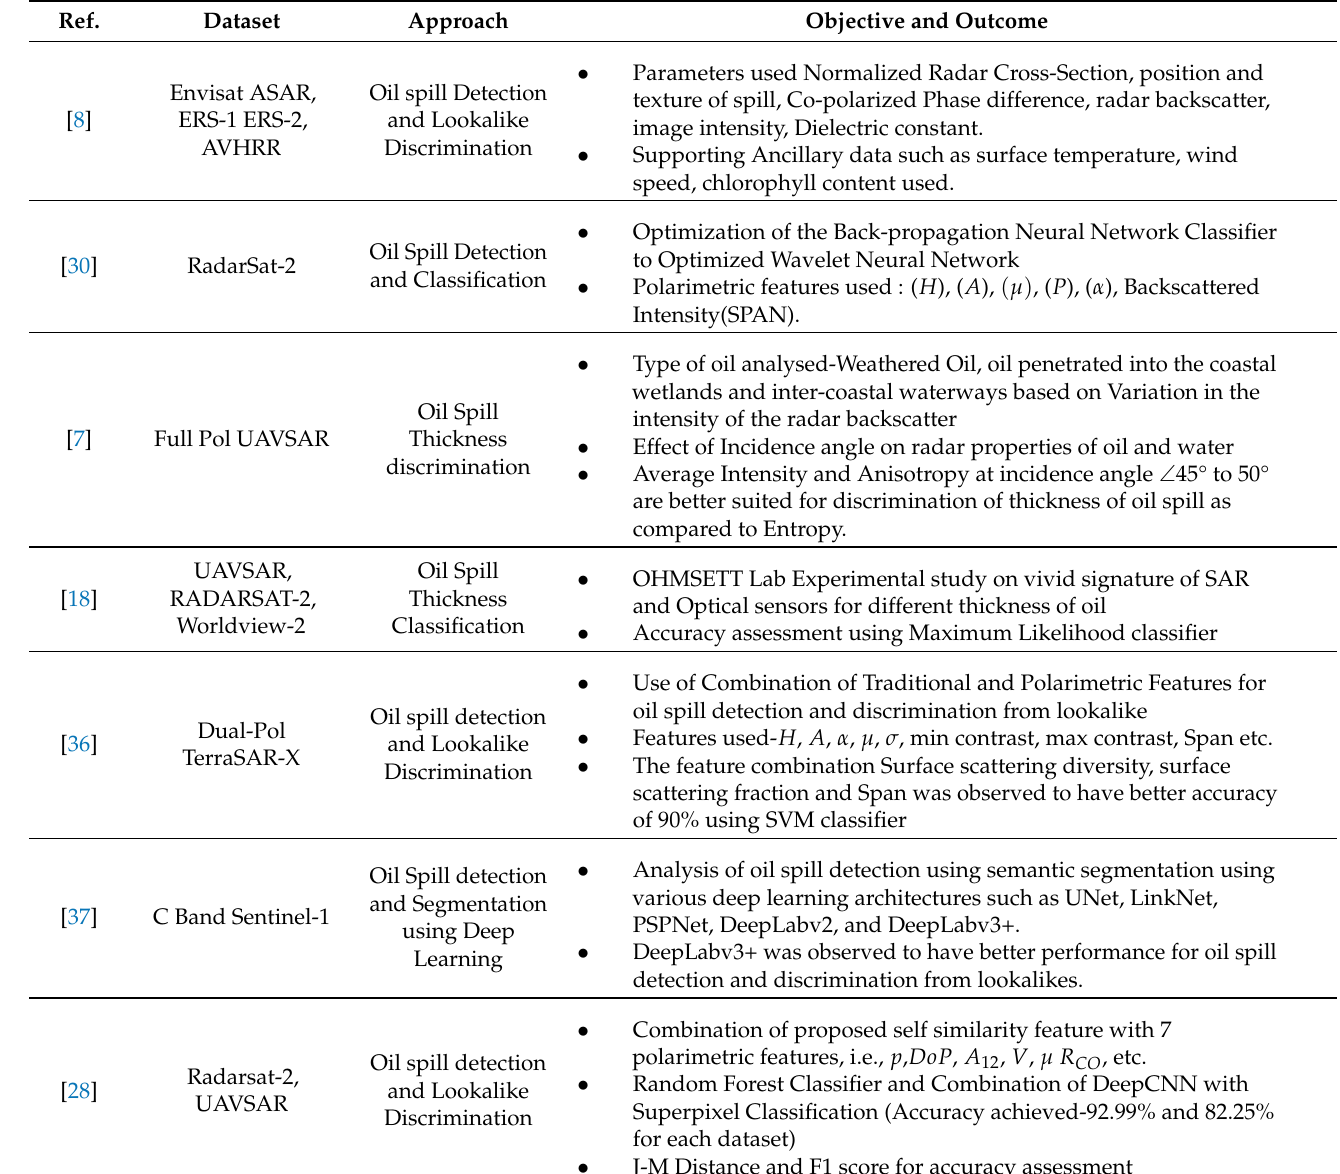
Table 1. Summary of recent research on oil spill detection using SAR Polarimetry.